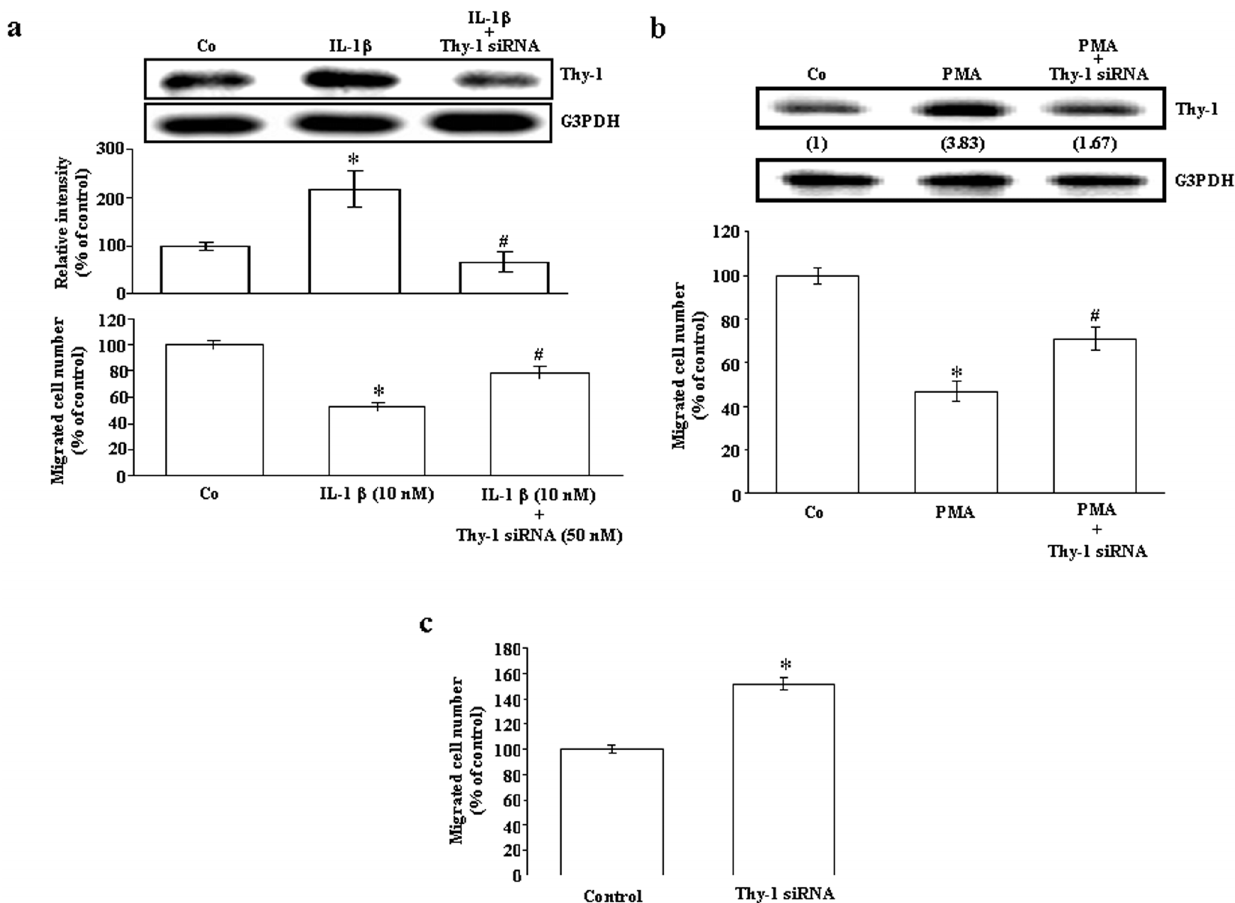
Figure 2. Role of Thy-1 in HUVEC migration. (a) Treatment of HUVEC with IL-1 b (10 nM) for 24 h significantly increased the level of Thy-1 protein and decreased the migrated cell number. Values represent the means 6 s.e.mean. (n=4). * p , 0.05 different from control group. # p , 0.05 different from the IL-1 b -treated group. (b) Treatment of HUVEC with PMA (20 ng/mL) for 24 h caused a 3.83-fold increase of the Thy-1 protein level (upper panel) and a 54% reduction of the migrated cell number (bottom panel). Values represent the means 6 s.e.mean. (n=4). * p , 0.05 different from control group. # p , 0.05 different from the PMA-treated group. (c) Transfection with Thy-1 siRNA increased the HUVEC migration. Values represent the means 6 s.e.mean. (n=3). * p , 0.05. Co,